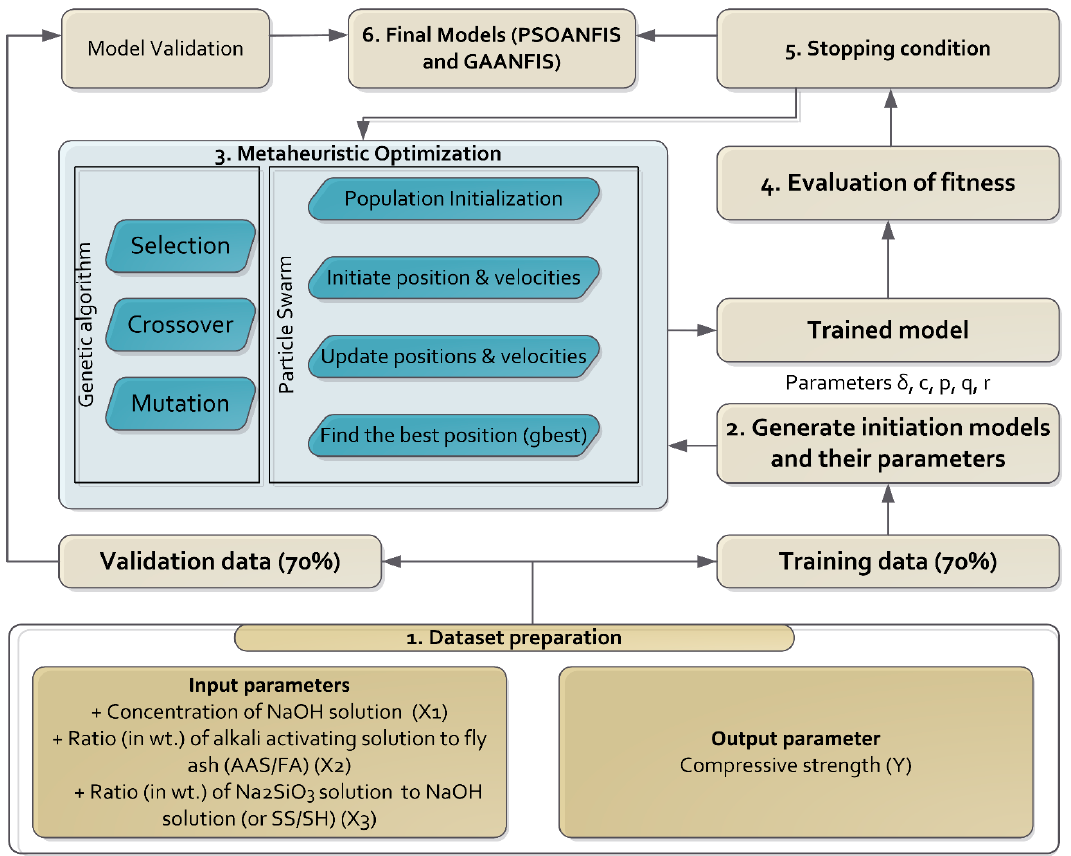
Figure 5. Modeling methodology flow chart of this study.